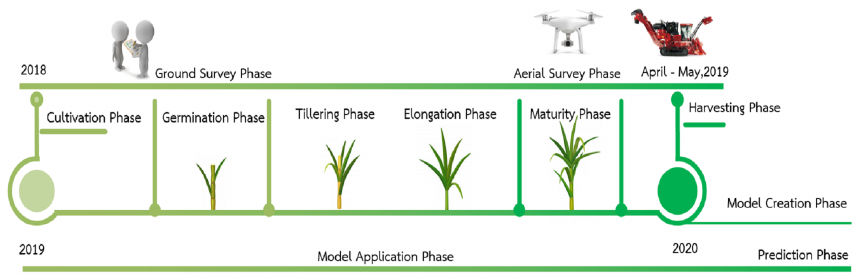
Figure 3. Diagram of the data collection